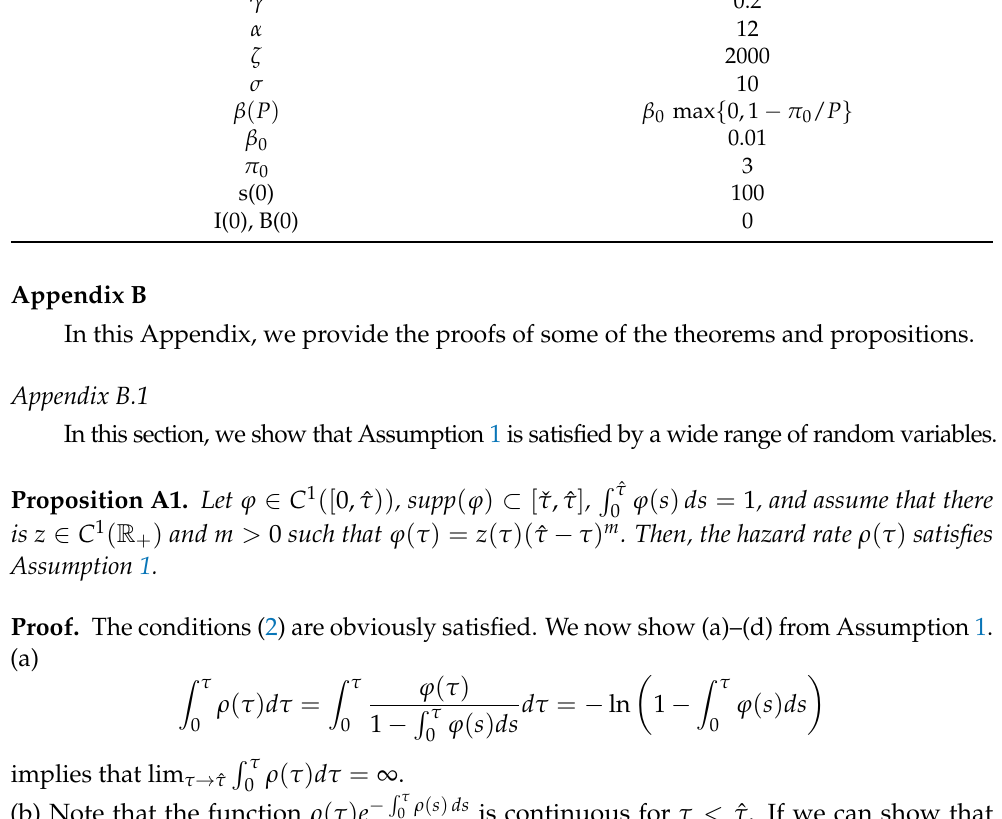
Table A1. Parameter values. Parameter Value ˇ